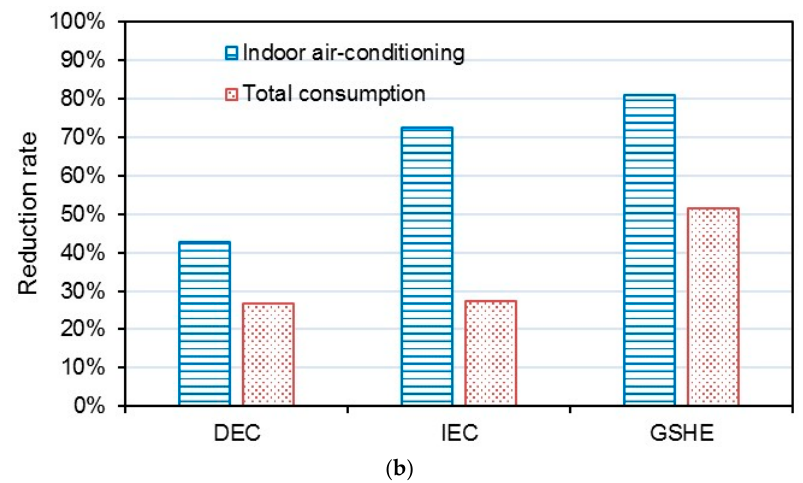
Figure 12. Seasonal electricity consumption of the office: ( a ) Accumulated amount; and ( b ) Reduction rate.